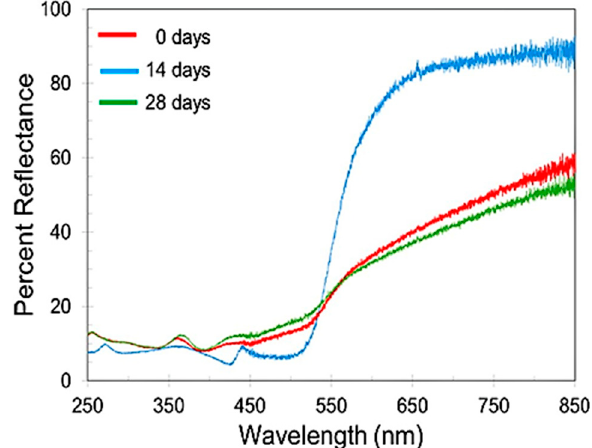
Figure 8. UV-Vis diffuse reflectance spectra showing the light stability of CsAgBiBr 6 after two and four weeks of light exposure. Reproduced with permission from Reference [36]. American Chemical Society, 2016.